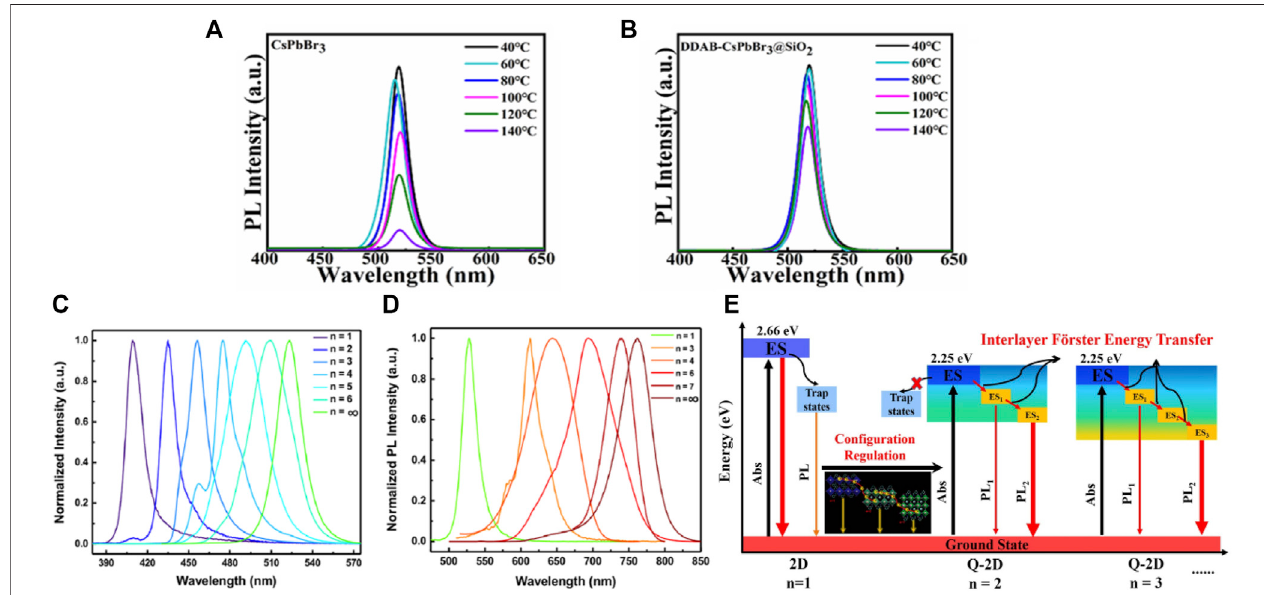
FIGURE 4 | (A,B) PL spectra of CsPbBr 3 and DDAB-CsPbBr 3 @SiO 2 QD fi lms annealed at different temperatures for 10 min (Zhu et al., 2021); (C,D) PL emission spectra of 2D QDs with for Brand I based perovskite (Yi-Hsuan Chang et al., 2018); (E) The schematic diagram of the photophysical processes (Ma et al., 2021).